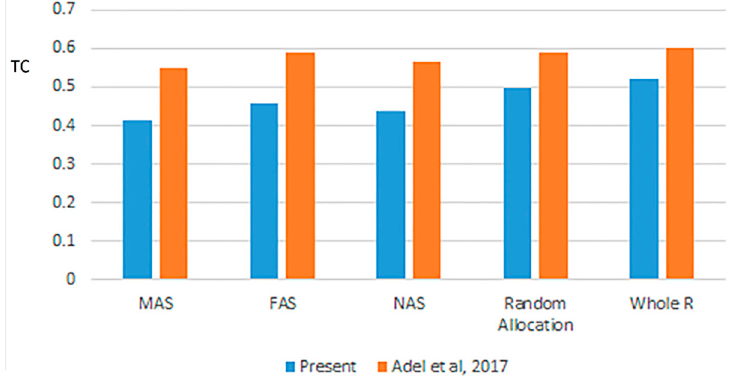
Figure 9. Problem 1, TC minimization in percentage for all scenarios for our proposed work.